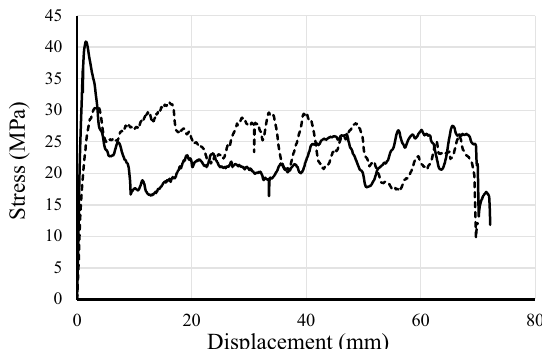
Fig. 11 Comparison of stress–displacement curves of MDF for different ph values . The solid curve is the stress–displacement curve when ph 1 and the dotted curve when ph = were as follows: d 12 mm and dowel position =